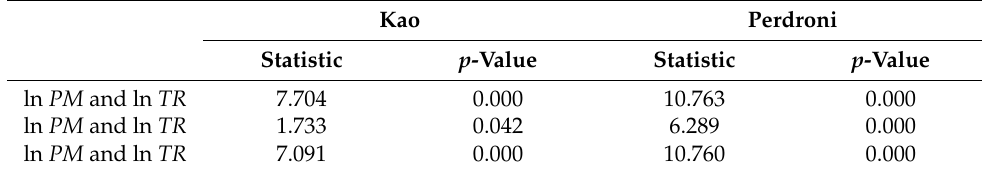
Table 3. The results of cointegration